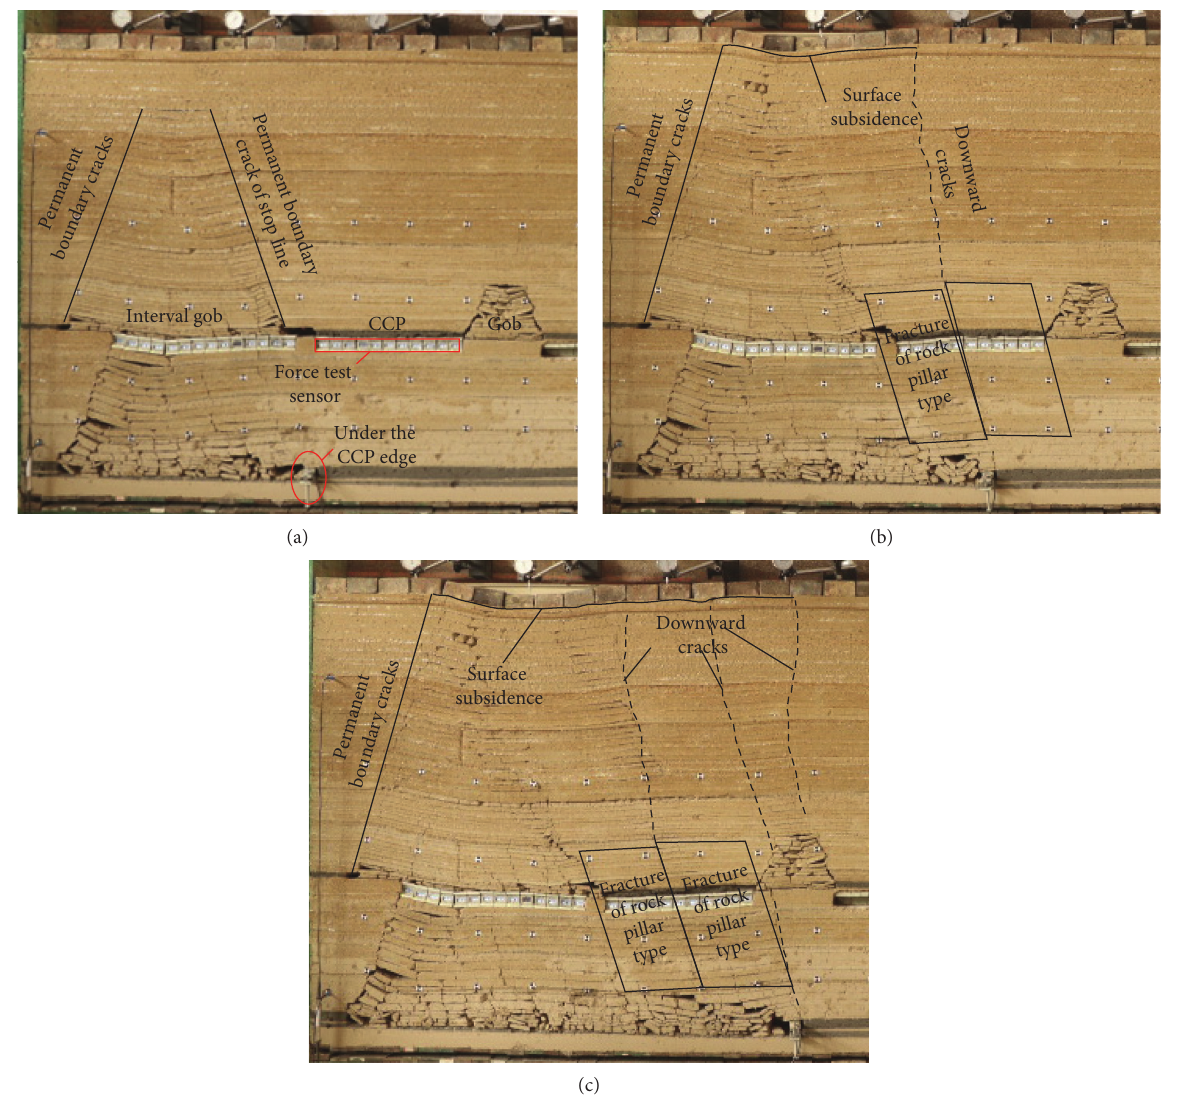
Figure 4: Collapse characteristics of overlying strata of concentrated coal pillar in working face. (a) Approaching the concentrated coal pillar. (b) 25m under the concentrated coal pillar. (c) 7m beyond the concentrated coal